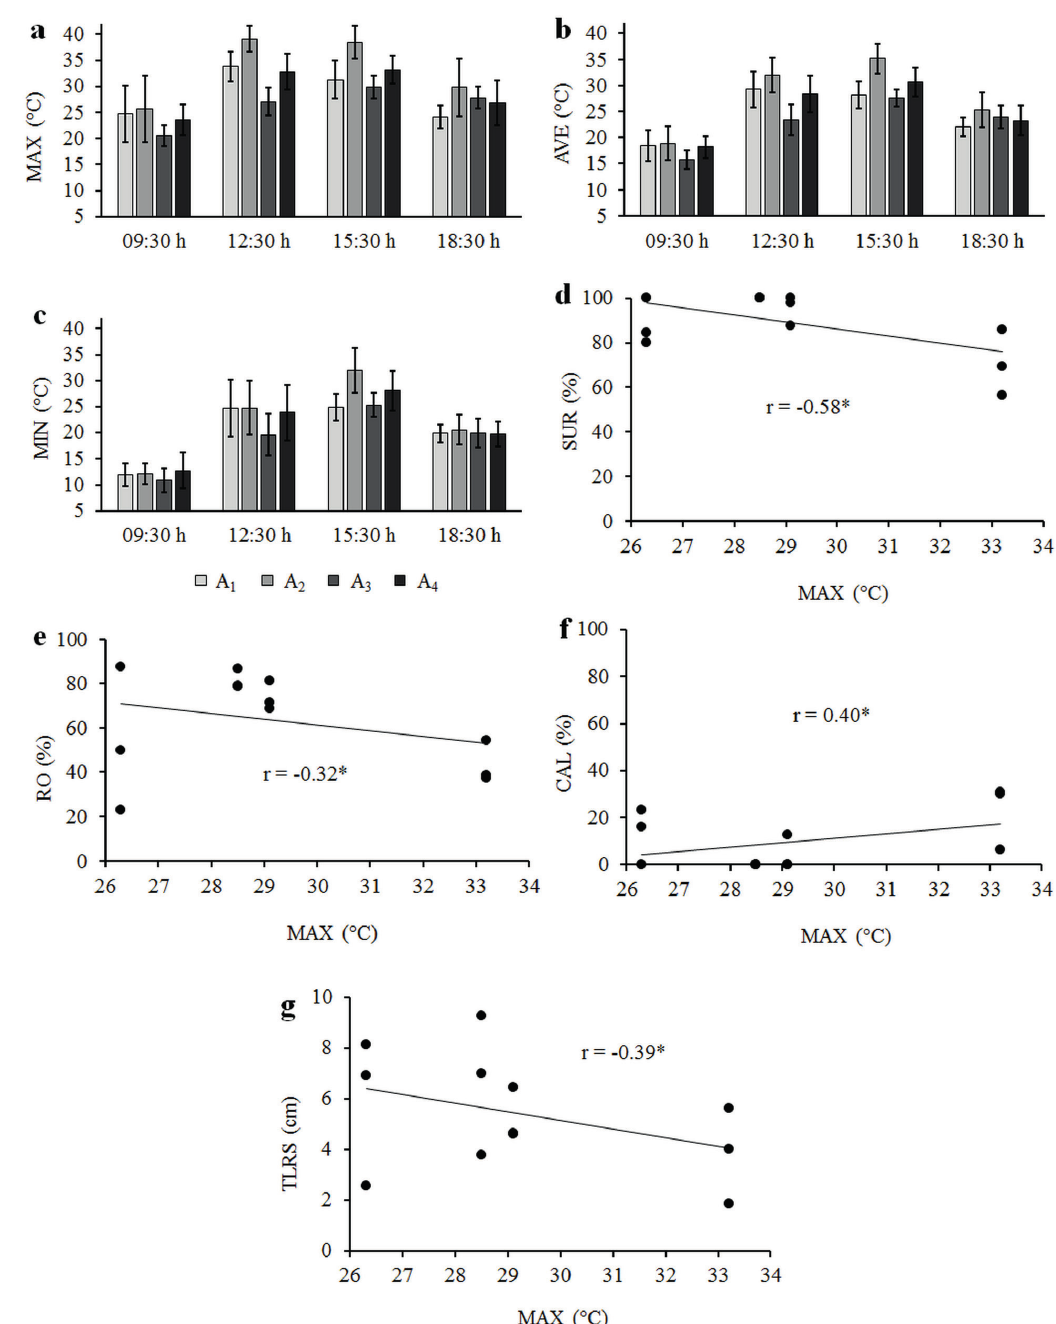
Figure 4 - Air temperatures in mini-incubators placed in four distinct environments. a – Mean values of the maximum (MAX), b – average (AVE), and c – minimum (MIN) temperatures. d – Pearson correlation between maximum air temperature (MAX) in the mini-incubators of the percentage of survival (SUR), e – percentage of adventitious rooting (RO), f – percentage of callogenesis (CAL) and g – the total length of the adventitious root system (TLRS) of microcuttings of Eucalyptus and Corymbia . A – shade house with no fogging; A – greenhouse with ventilation but no 1 2 fogging; A – greenhouse with both ventilation and fogging; A – greenhouse with no ventilation but with fogging. The 3 4 values are presented as the mean ± standard error. *Significant value ( P <